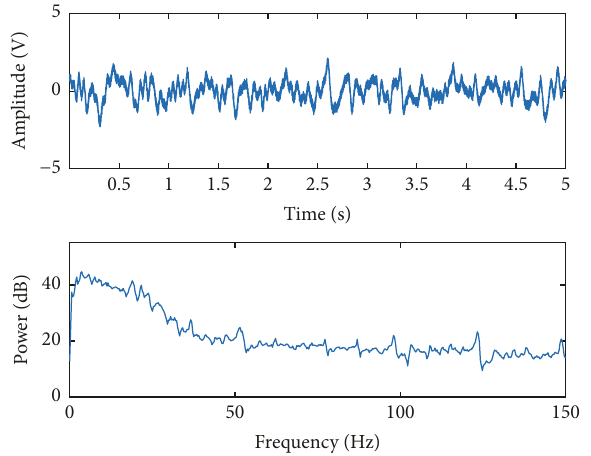
Figure 17: Received signal and power spectrum when the trans- ducer frequency is 45 Hz and flow meter value is 0.86 m/s.